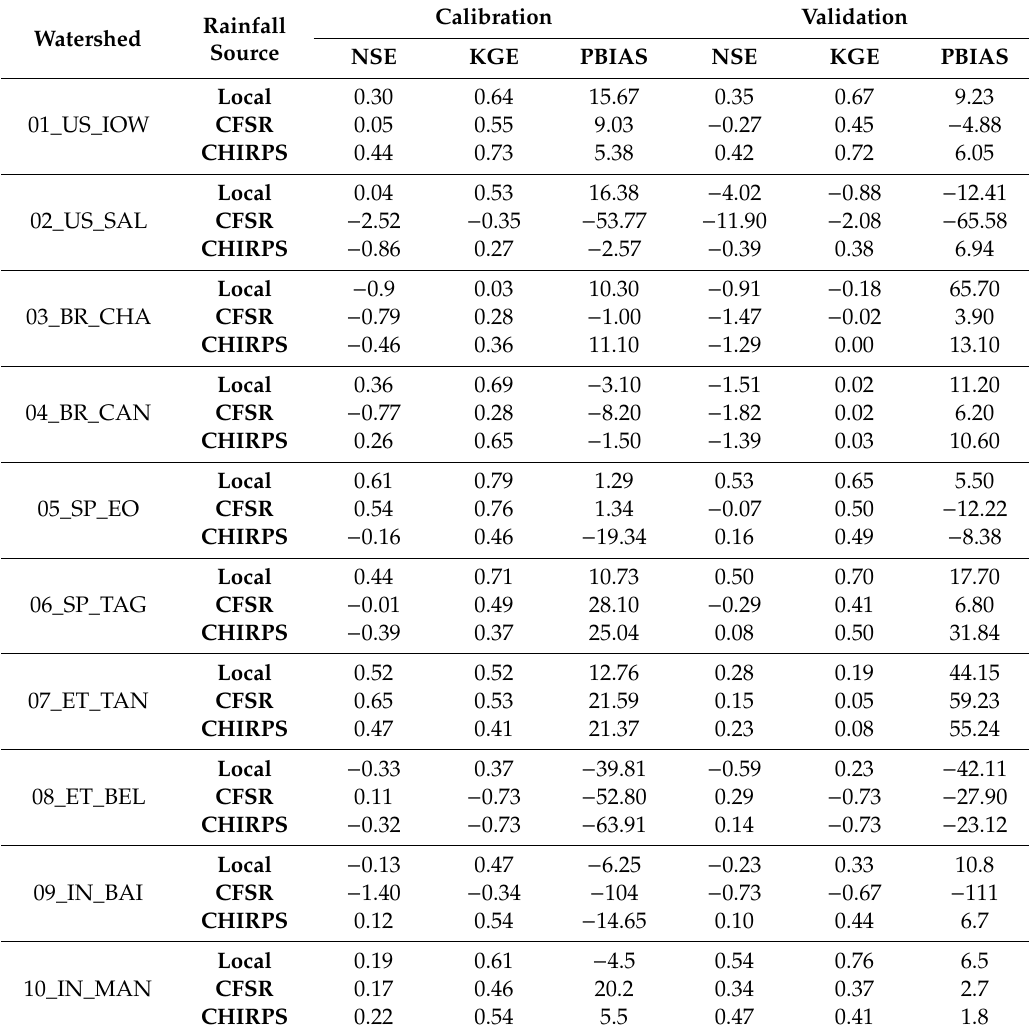
Table 7. Model performance for the calibration and the validation period at the daily scale.